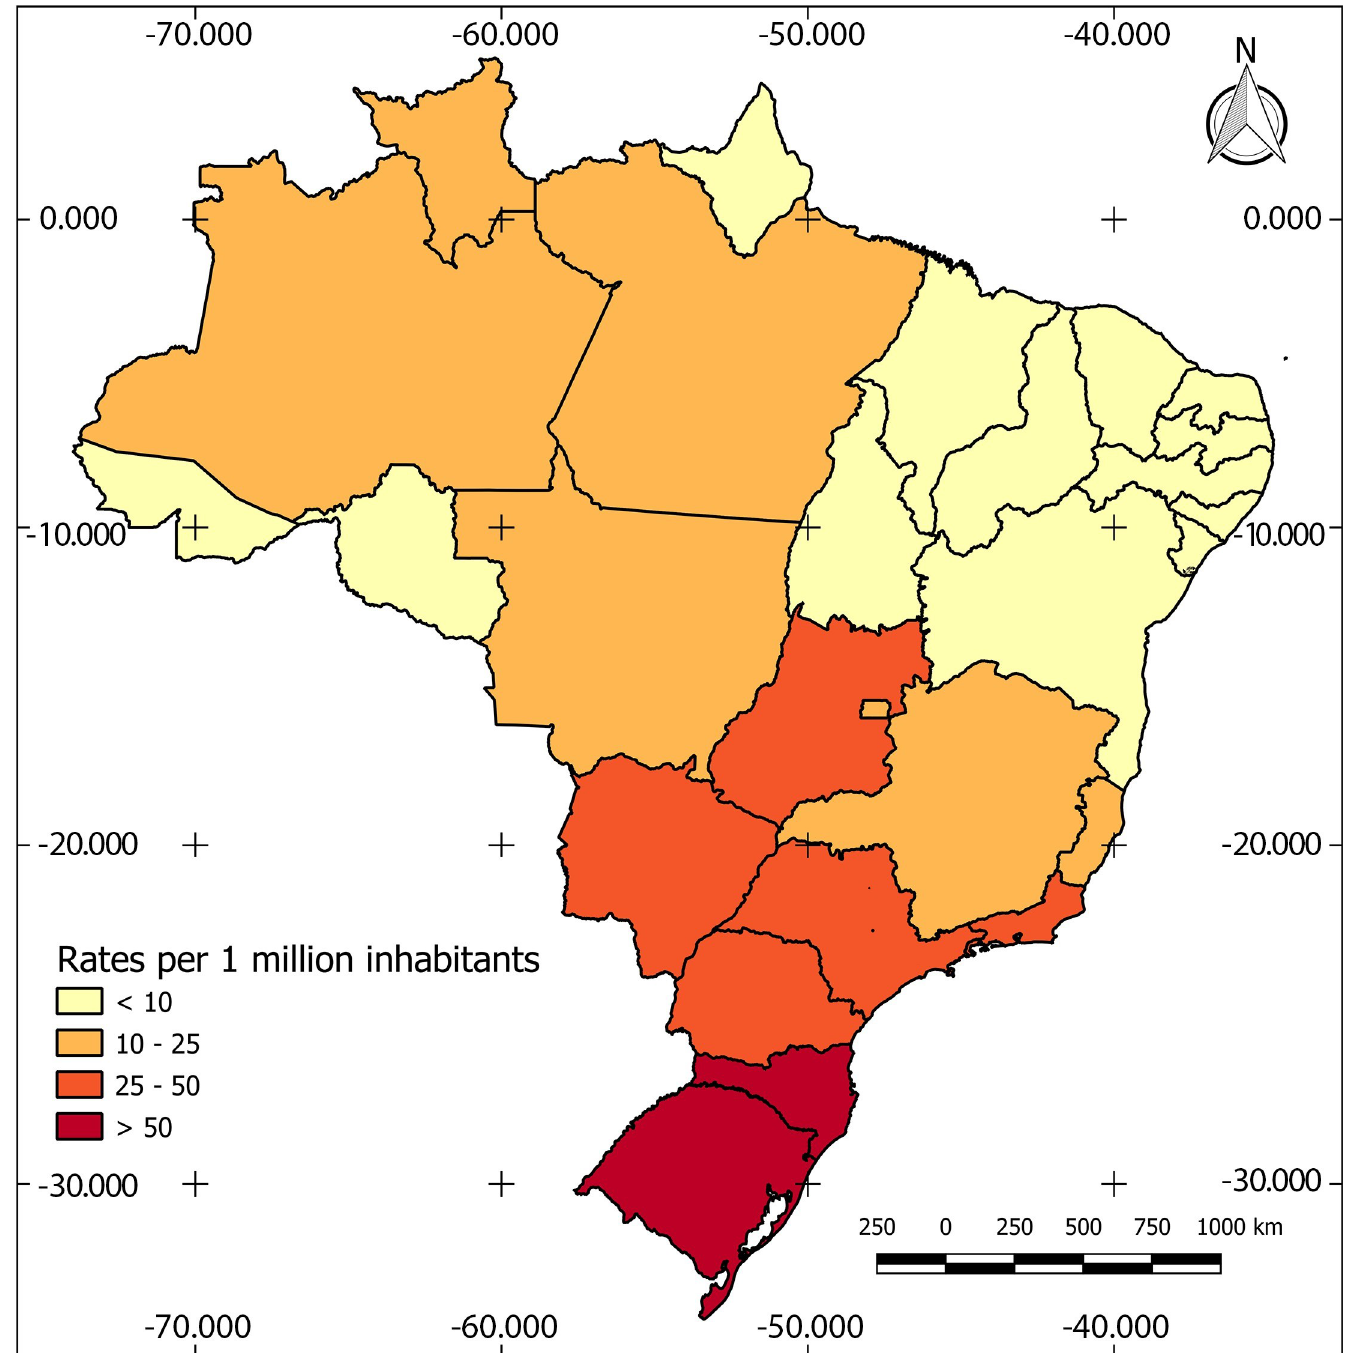
Fig 2. Distribution of mortality rates � by cryptococcosis (associated causes) according to States. Brazil, 2000 to 2012. Source: DATASUS/MS and IBGE. � : mortality rates per 1,000,000 inhabitants. The distribution of cryptococcosis deaths according to gender and by all mentioned causes showed a preponderance among males. When associated with AIDS (71.2%), crypto mortality with data from the literature [16, 21].